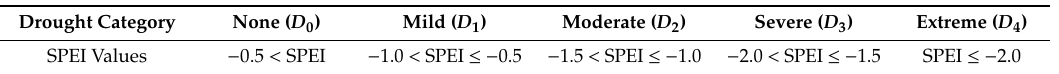
Table 2. Classification scale for the standardized precipitation evapotranspiration index (SPEI) and their drought